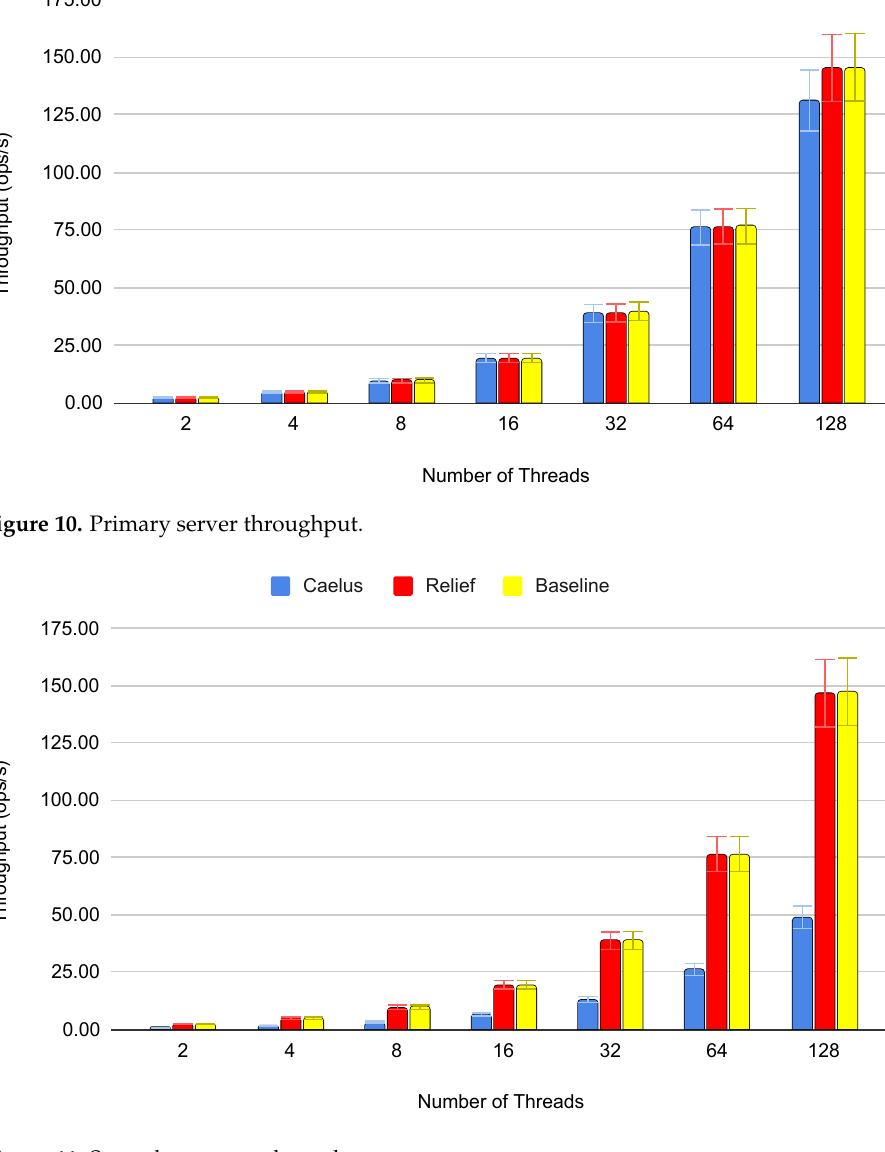
Figure 11. Secondary server